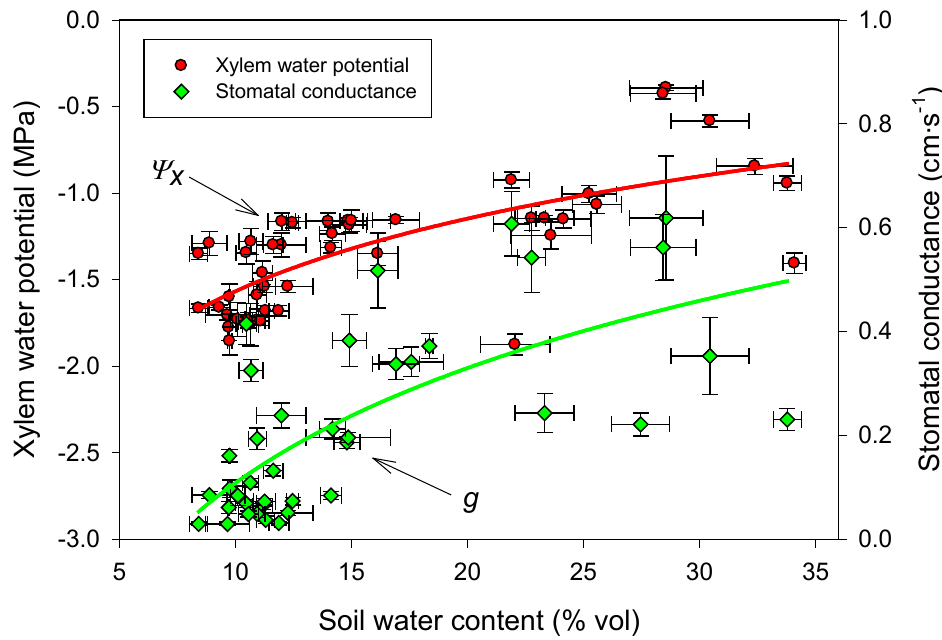
Figure 6. Relationships between midday xylem water potential and midday stomatal conductance as a function of soil water content in Abies pinsapo trees along an altitudinal gradient (low elevation, 1200 m; high elevation, 1550 m) measured during two consecutive growing periods. Errors bars represent the standard error. Both midday xylem water potential ( R 2 = 0.48, p < 0.001) and midday stomatal conductance ( R 2 = 0.51, p < 0.001) showed a logarithmic relationship with soil water